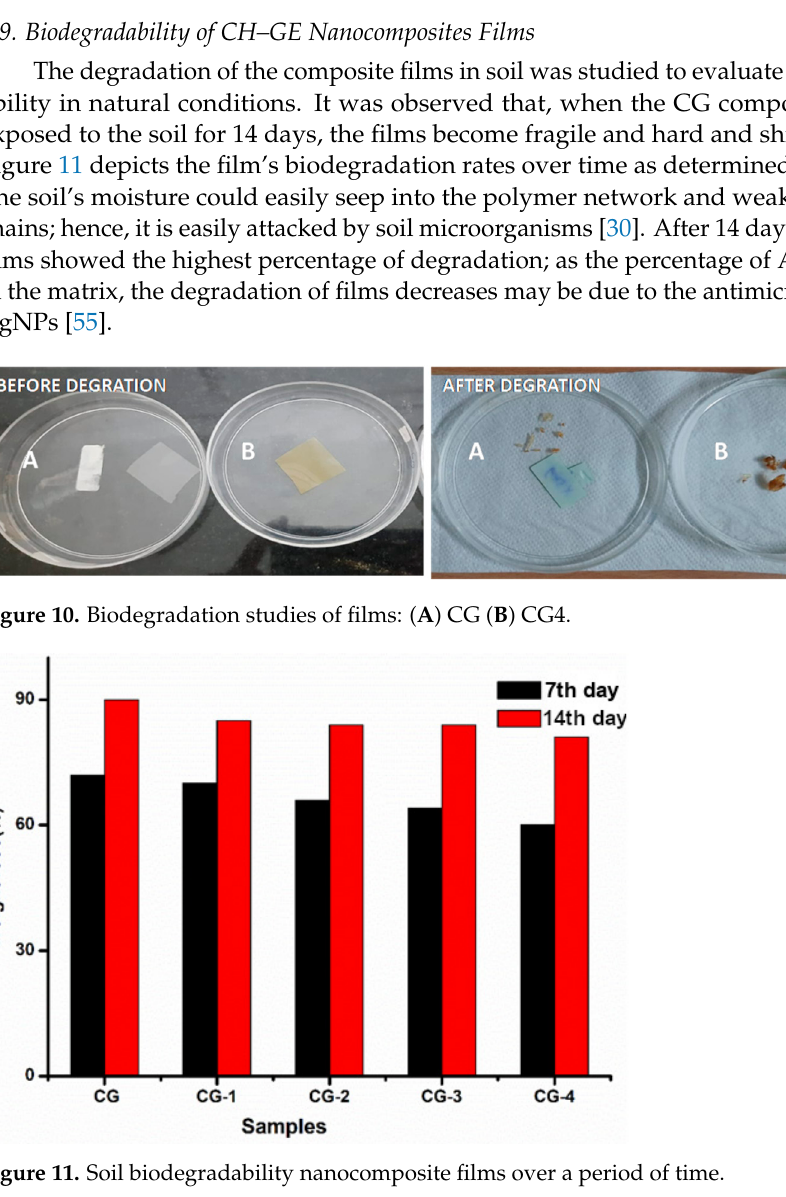
Figure 10. Biodegradation studies of films: ( A ) CG ( B ) CG4.